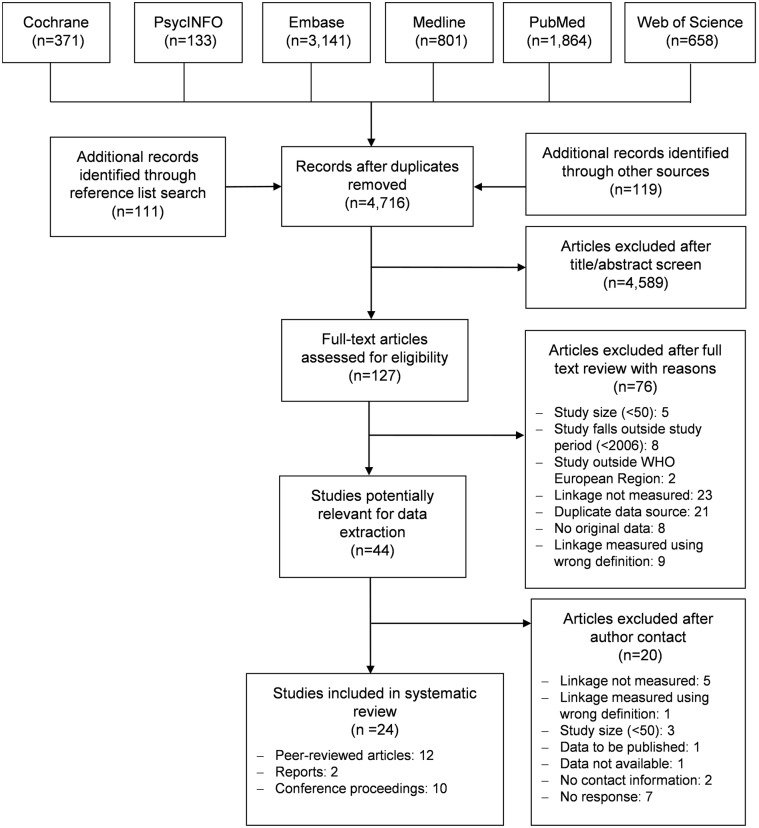
PRISMA (Preferred Reporting Items for Systematic Reviews and Meta-Analyses) flow diagram.